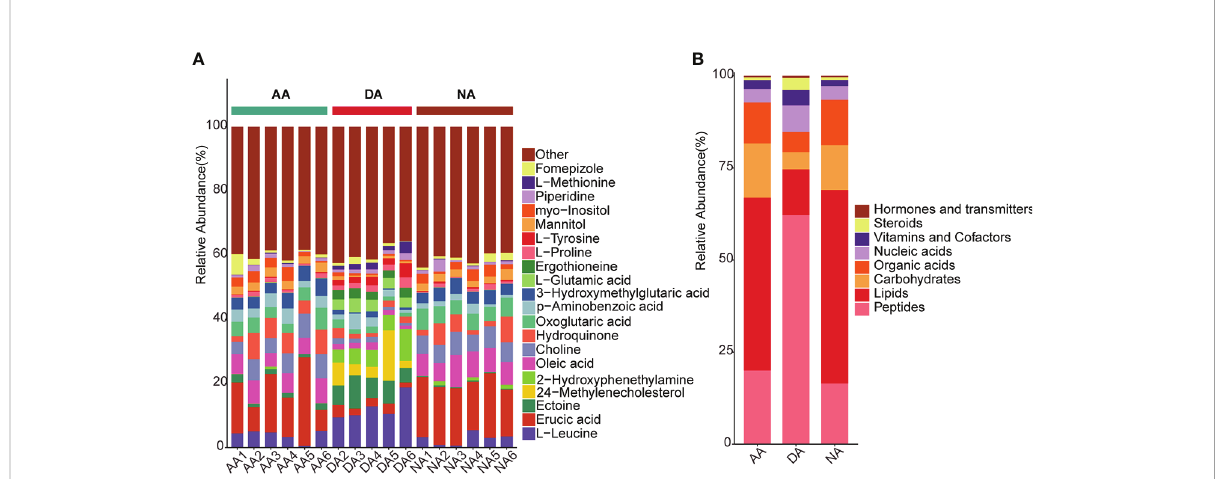
FIGURE 1 The annotated metabolites in A . japonicus during estivation cycles. (A) the relative abundance of top 20 metabolites in each group, (B) the relative abundance of the annotated metabolites in KEGG database in distribution of eight